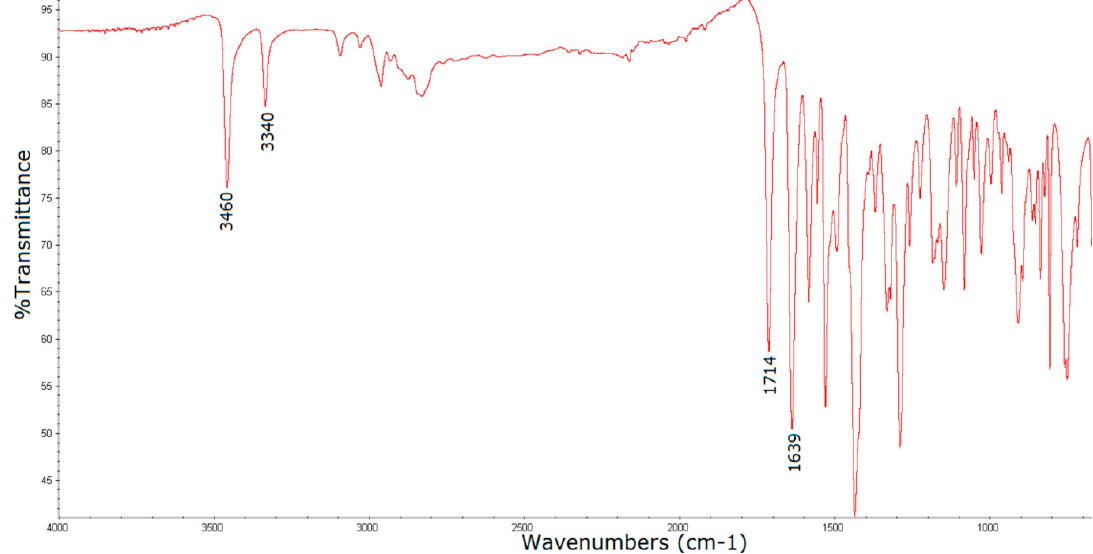
Figure 3. FTIR spectrum of sparfloxacin.